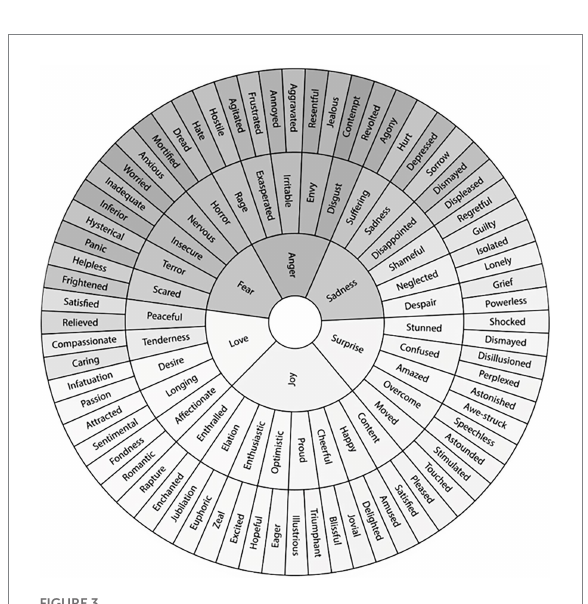
FIGURE 3 Emotion wheel used to select the emotion while